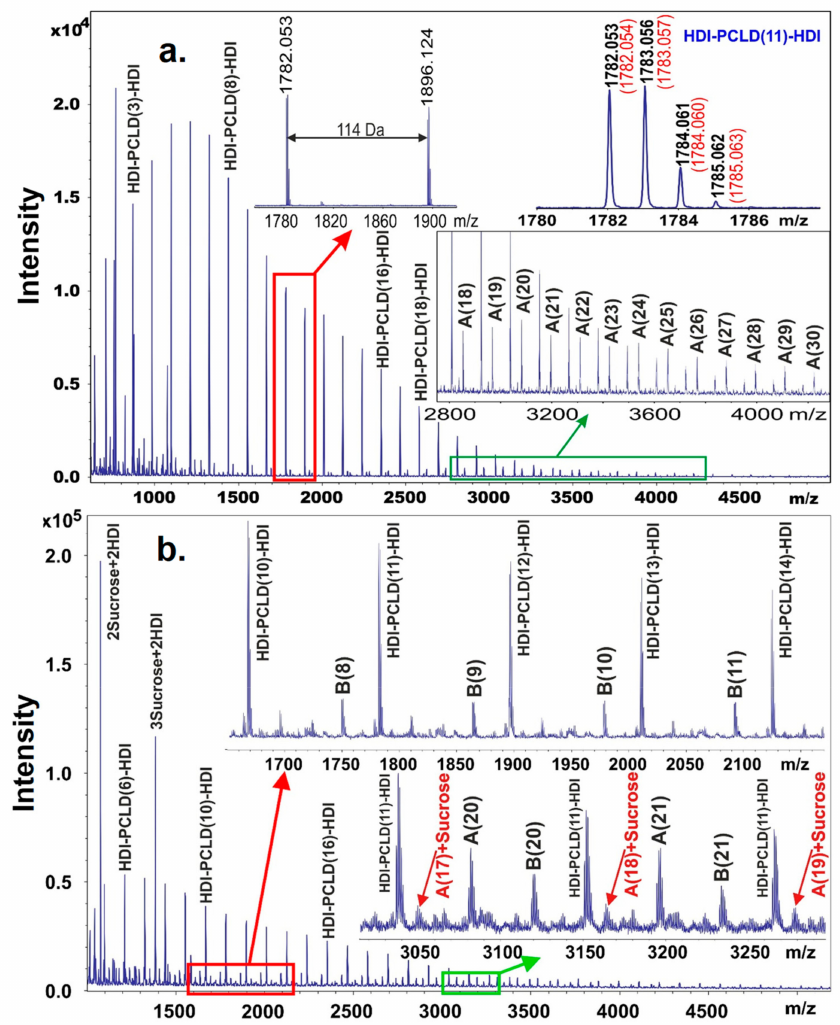
Figure 2. MALDI-TOF mass spectra of the samples obtained from the PCLD-HDI reaction mixture (Reaction conditions: temperature = 90 ◦ C, reaction time: 4 h) ( a ) and from the HDI-PCLD prepolymer sucrose reaction (Reaction conditions: temperature = 90 ◦ C, reaction time: 3 min, the molar ratio for PCLD / HDI / sucrose is 1 / 2.2 / 0.95, sample SPUR-1) ( b ). The numbers in the brackets represents the number of the caprolactone repeating unit. The isotopic distribution, the measured and the calculated (red in brackets) m / z values are shown in the inset (top right corner of Figure